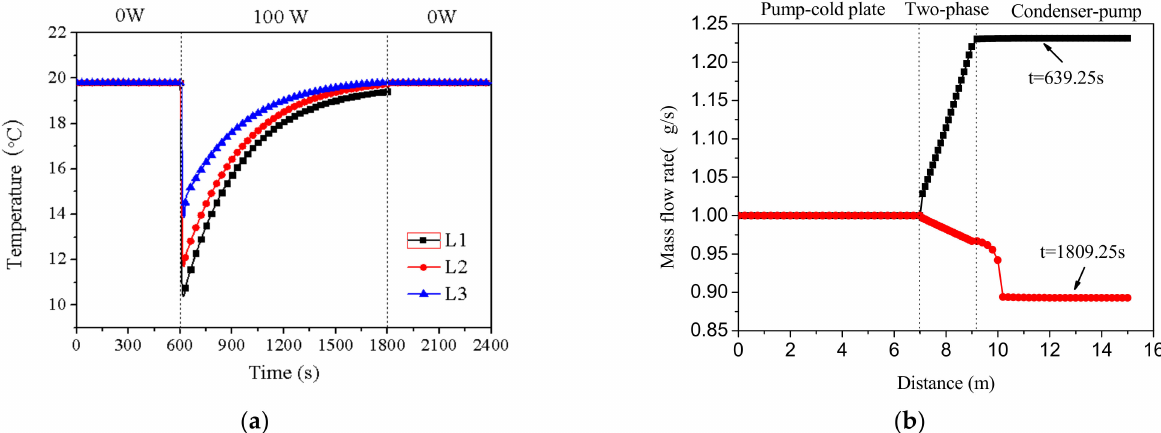
Figure 7. ( a ) Temporal evolution of temperature at different locations of the transport pipe be- tween the accumulator and main loop; ( b ) profile of mass flow rate along the flow distance of the MPTL